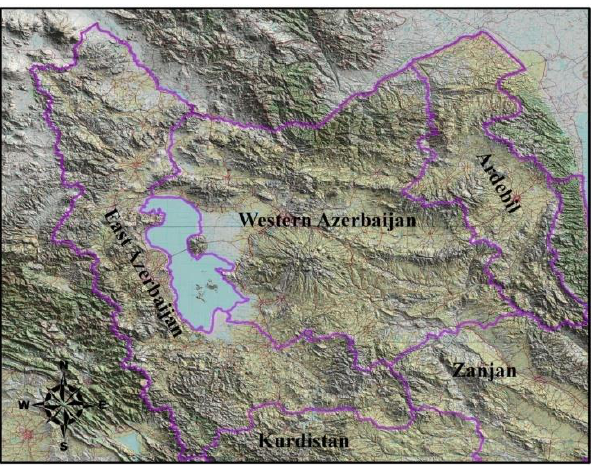
Figure 1: Location of Urmia Lake in the Country ( Author)